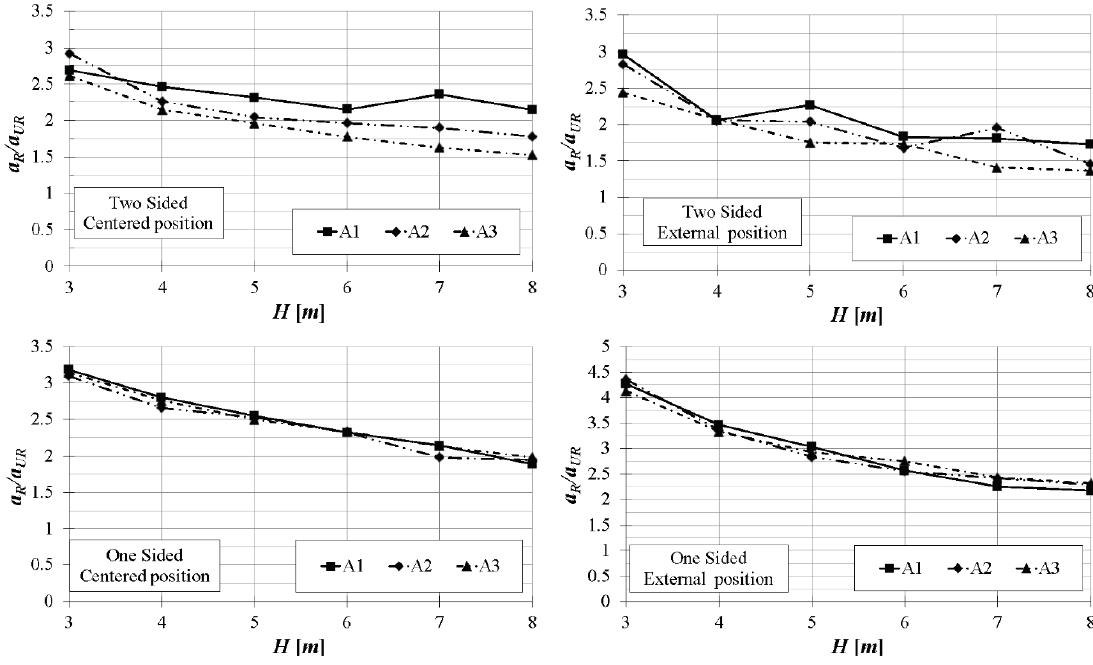
Figure 15. Level of seismic improvement versus height H — α =7.5, ρ =2‰, GFRP material.